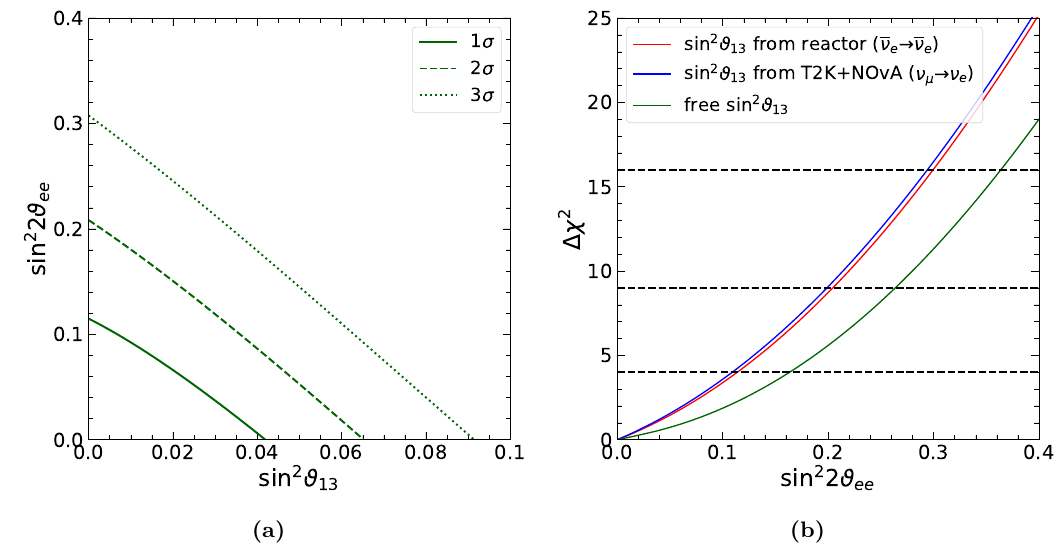
Figure 9. (a) Allowed region in the ( sin 2 ϑ 13 , sin 2 2 ϑ ee ) plane from the global solar data with free sin 2 ϑ 12 . (b) The one-dimensional ∆ χ 2 profiles of sin 2 2 ϑ ee , where the red line corresponds to the analysis including the sin 2 ϑ 13 constraint from PDG 2020 [71], the blue line is for the case of sin 2 ϑ 13 constrained by neutrino data from T2K and NOvA [72], and the green line corresponds to the case with unconstrained sin 2 ϑ 13 .